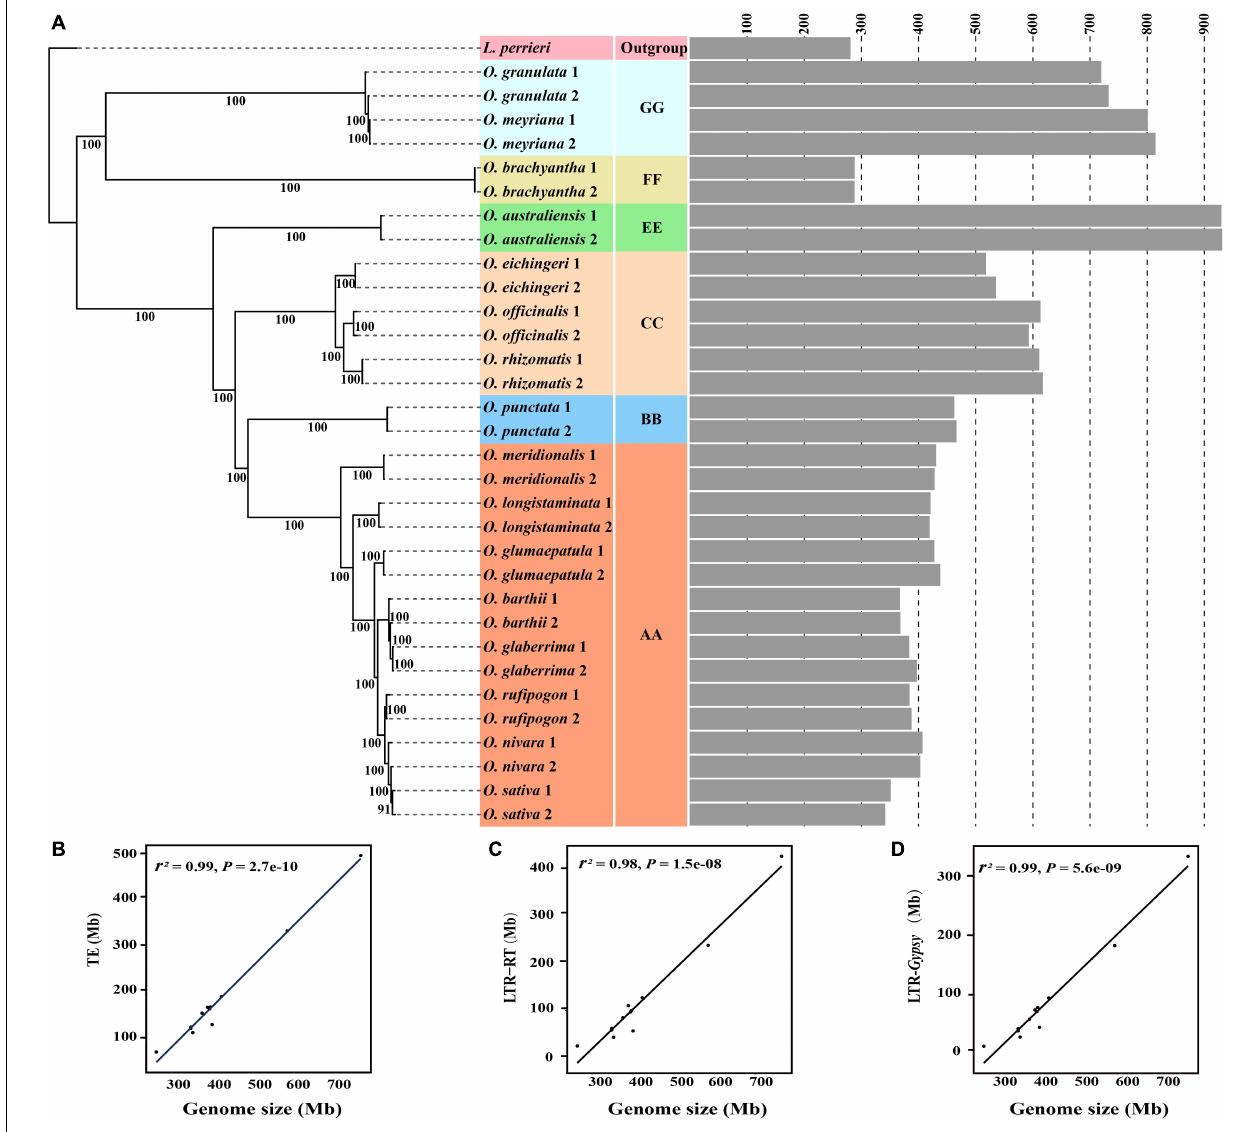
FIGURE 2 | Evolutionary dynamics of genome sizes and transposable elements across the diploid Oryza species. The phylogenetic tree was constructed based on the SNPs located on fourfold-degenerate sites (A) . The gray bar graph represents the genome size estimated by using k -mer analysis. The number of branches represents the bootstrap values. The correlation is shown between genome sizes and TEs (B) , LTR-RTs (C) , and LTR/ Gypsy -RTs (D) ,